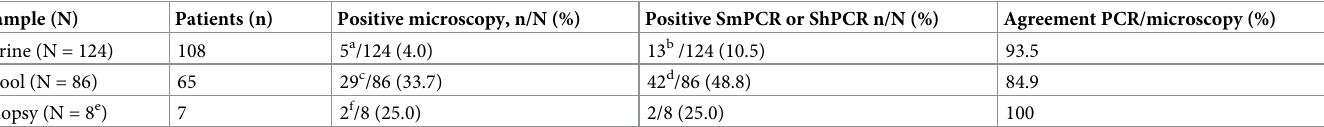
Table 1. Performance of PCR and microscopic examination for the detection of S . mansoni and S . haematobium in urine, stool and biopsy samples. Sample